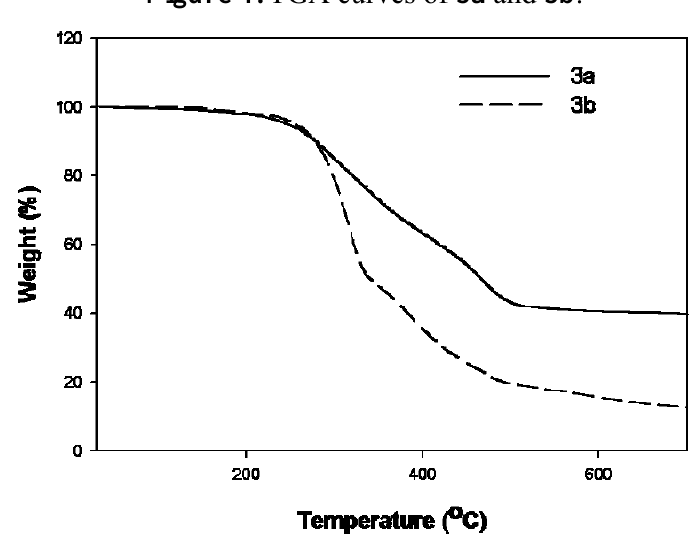
Figure 4. TGA curves of 3a and 3b